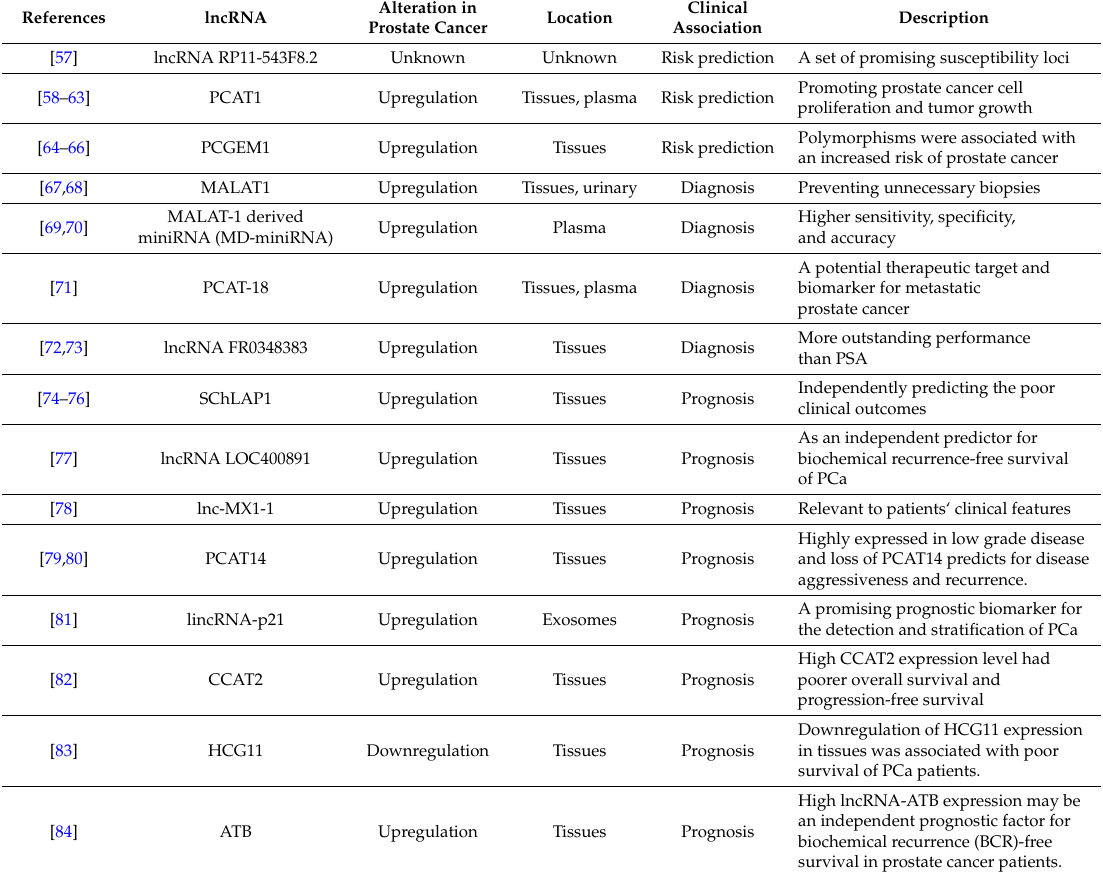
Table 4. Potential lncRNA biomarkers under investigation in prostate